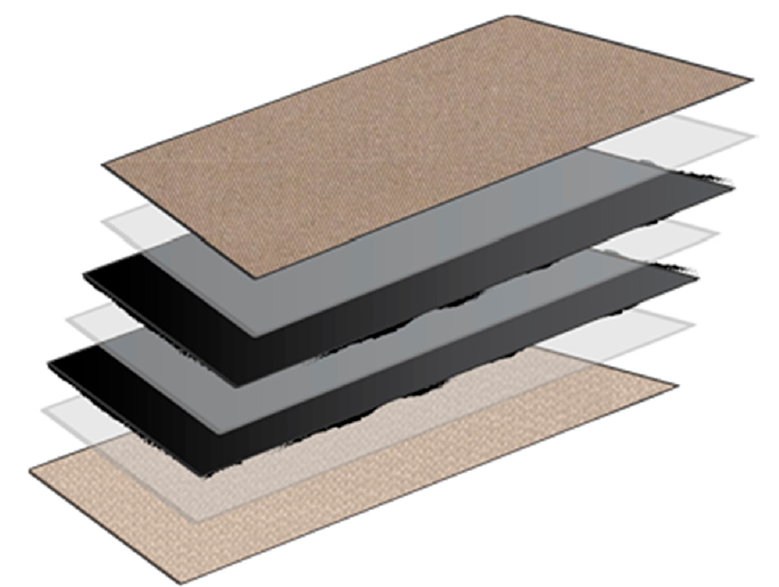
Figure 20. Composited textile with CHM layers (black) inside (figure by Ashley Kubley).